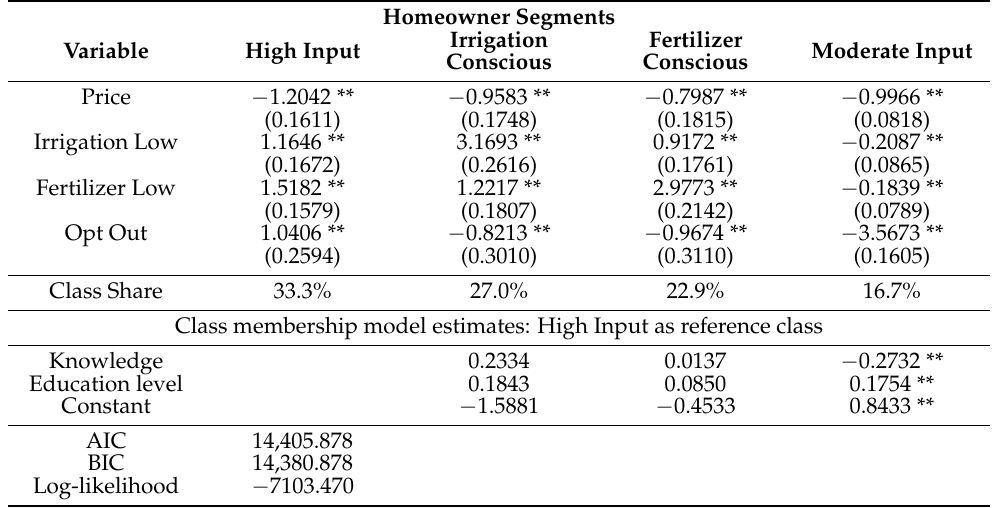
Table 3. Parameter estimates of the latent class logit model.